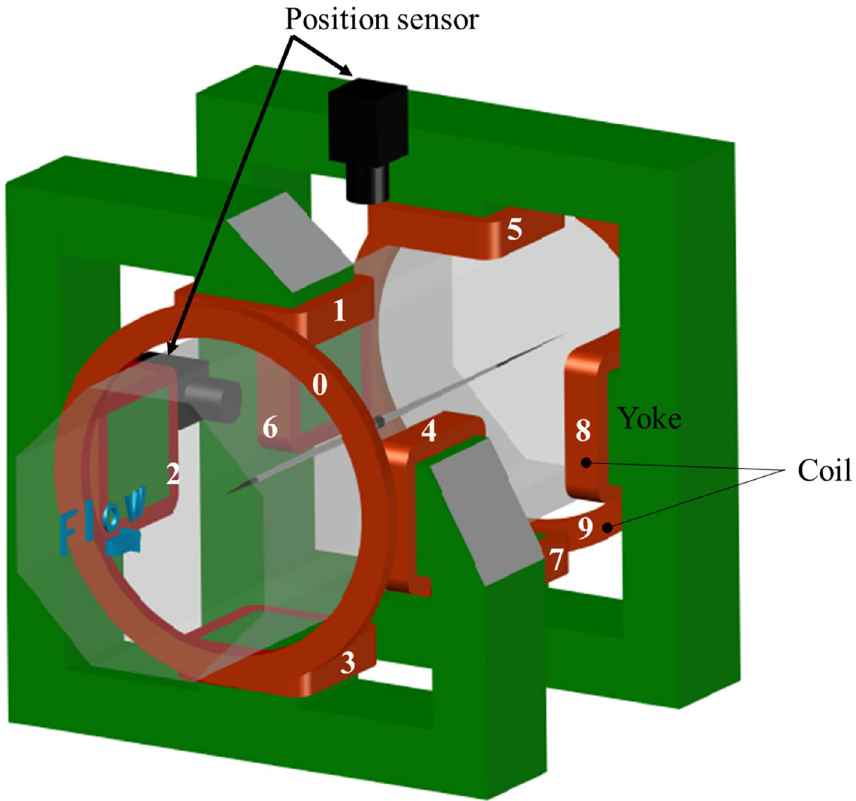
Figure 1. A schematic of the magnetic suspension and balance